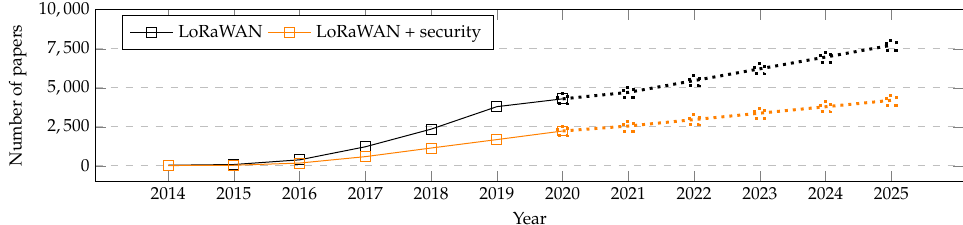
Figure 1. Results of the keyword search for the terms “LoRaWAN” and “LoRaWAN” + “Security” in Google Scholar for selected years 2014–2020 (predicted values are dotted). The correlation trend is R=0.893 with a square root of R 2